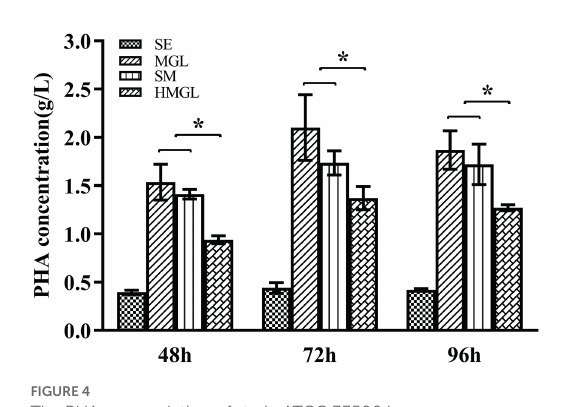
FIGURE 4 The PHA accumulation of strain ATCC 33500 in open fermentation using silkworm excrement as the carbon source. The PHA accumulation was detected by gas chromatography analysis in SE, MGL, SM, and HMGL medium. All the data are presented as means of duplicates with their standard errors [*significant differences ( p <